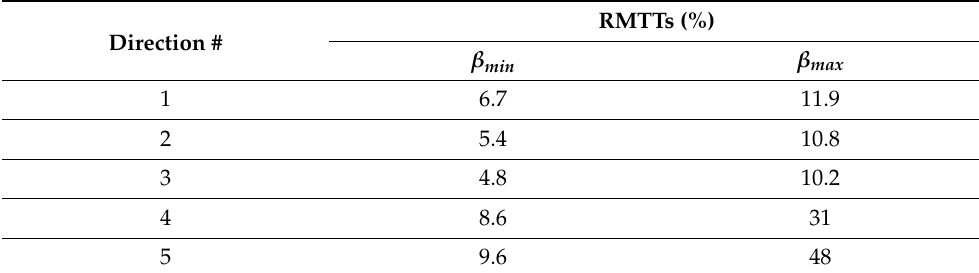
Table 3. Tone lower and upper limits for the five